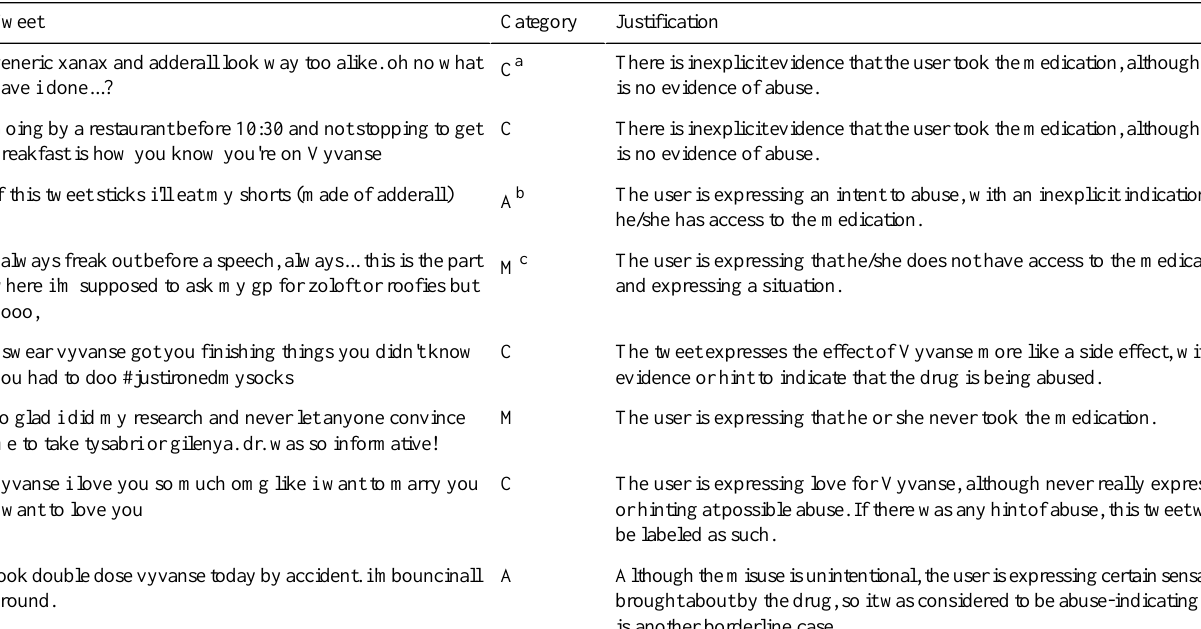
Table 4. Examples of difficult-to-annotate instances.